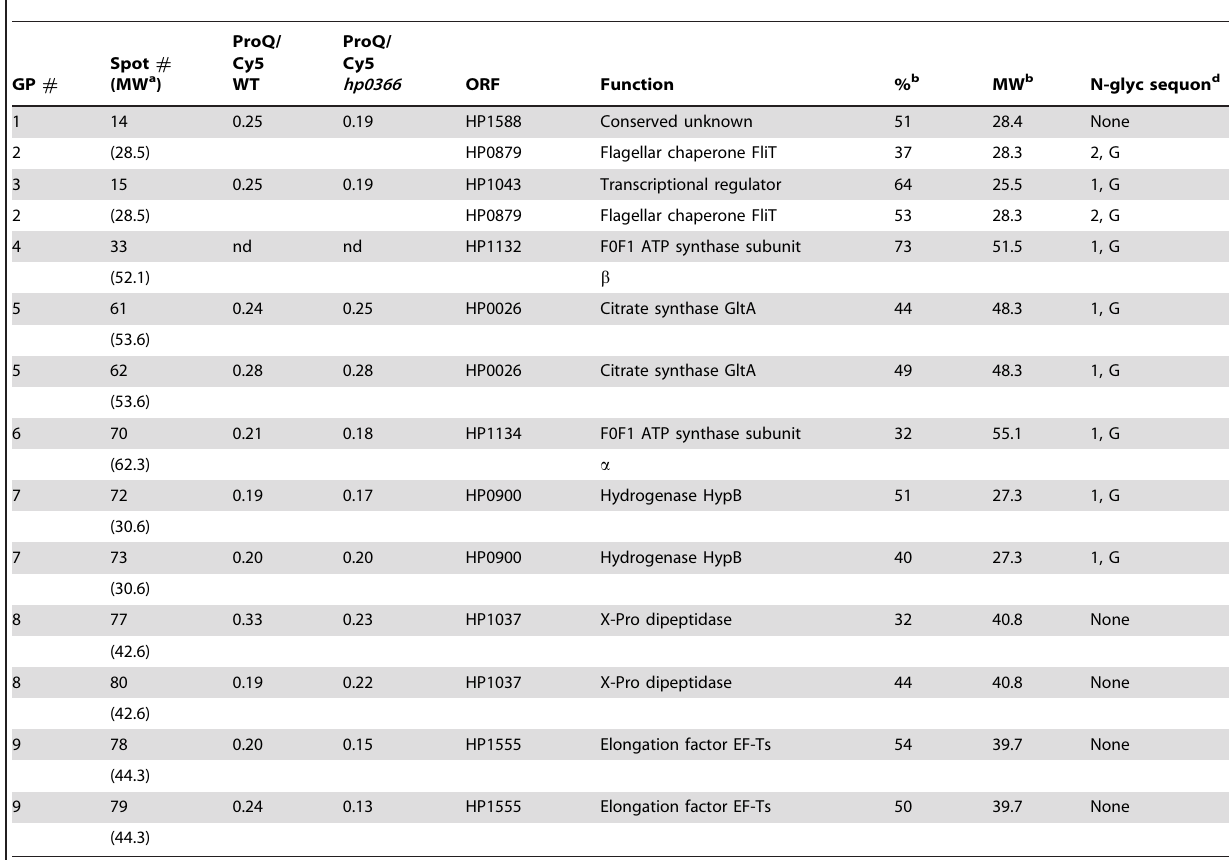
Table 2. Identification of candidate glycoproteins by ProQ-emerald